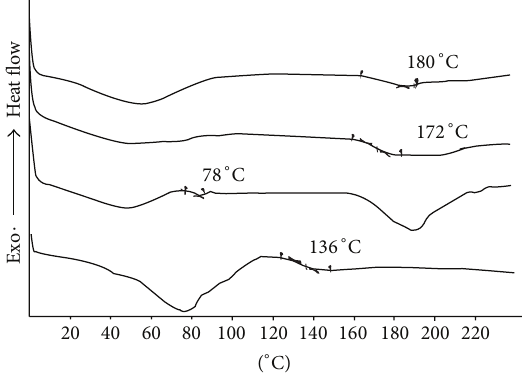
Figure 5: DSC thermogram of (a) magnetic copolymer GN73, (b) copolymer GN73, (c)poly(GMA), and (d)